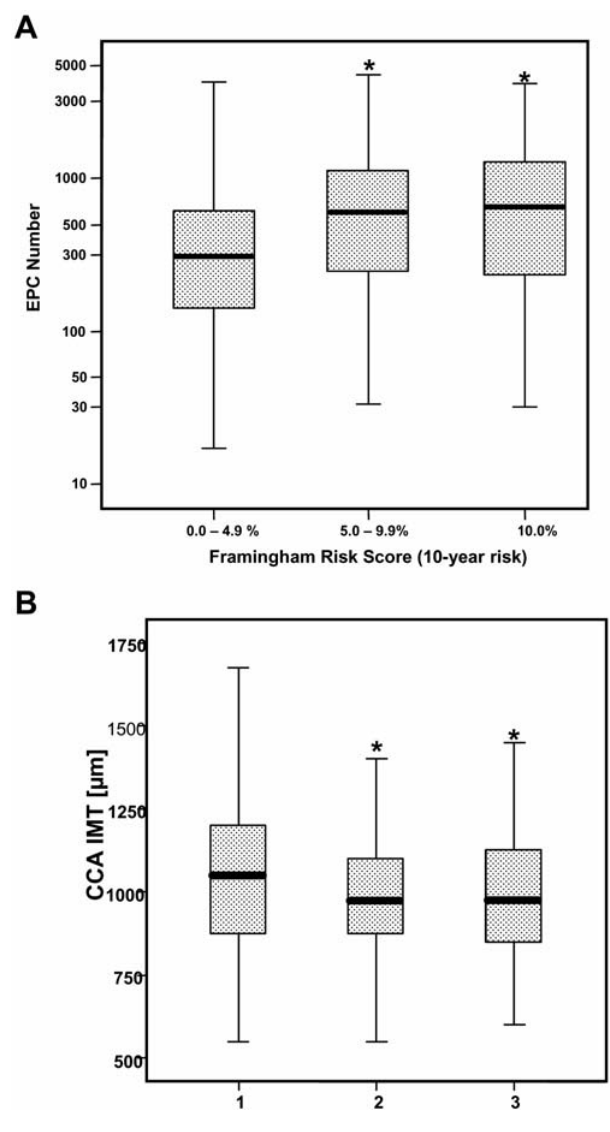
Figure 1. Panel A illustrates the association between EPC number (per 10 6 PBMNC) and the FRS (p=0.001). Panel B illustrates the association between IMT and EPC number (per 10 6 PBMNC) (p=0.02).